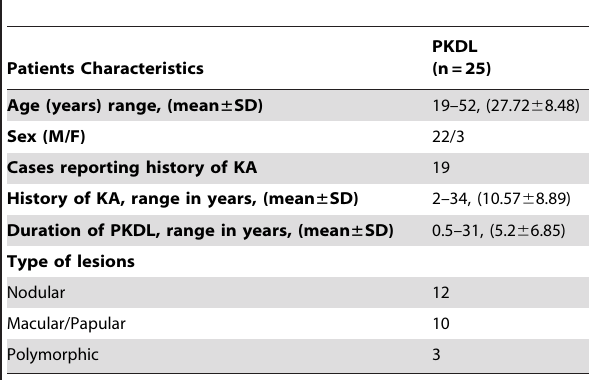
Table 1. Major characteristics of the study population.